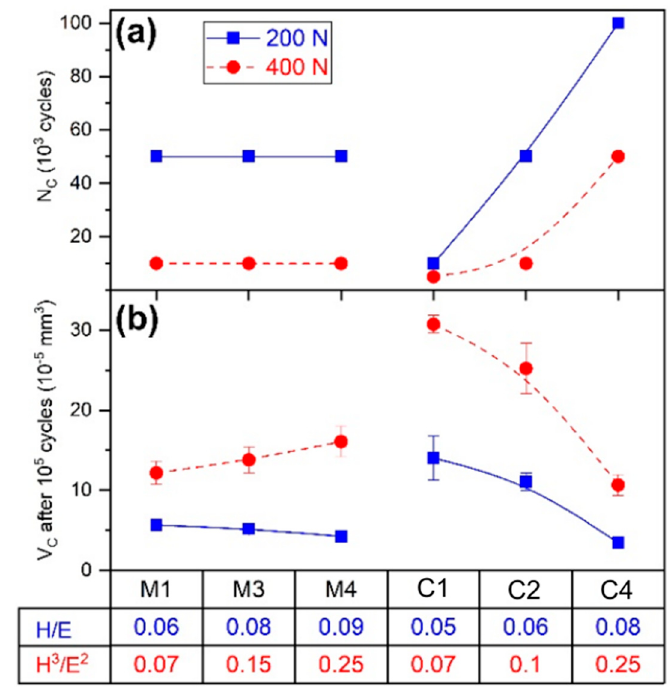
Figure 4. The critical number of impacts N C ( a ) and residual impact crater volume V C ( b ) after 10 5 load cycles. Comparison with H/E and H 3 /E 2 values corresponding to samples.